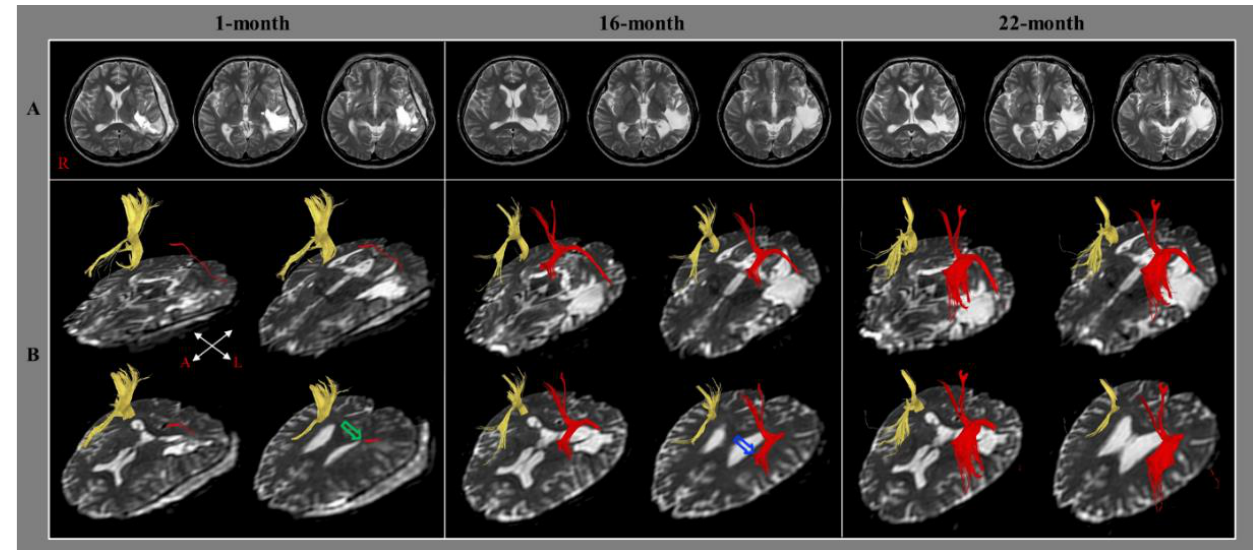
Figure 3. ( A ) Brain MR images at 1, 16, and 22 months after onset show leukomalatic lesions in the left parieto-temporal areas (R: right). ( B ) DTT for the arcuate fasciculus (right AF, yellow; left AF, red). The right AF passes through the known pathway of the AF. On 1-month DTT, the left AF showed discontinuation (green arrow) after originating from the Wernicke area. In contrast, on 16- month DTT, the injured left AF was thickened and elongated to around the left Broca area; however, discontinuation (blue arrow) of the left AF was observed around the left Broca area without termi- nation at the left frontal area. On 22-month DTT, the discontinuation of the left AF was elongated to the left Broca area and the left AF was thickened (reprinted with permission from Ref. [21]).